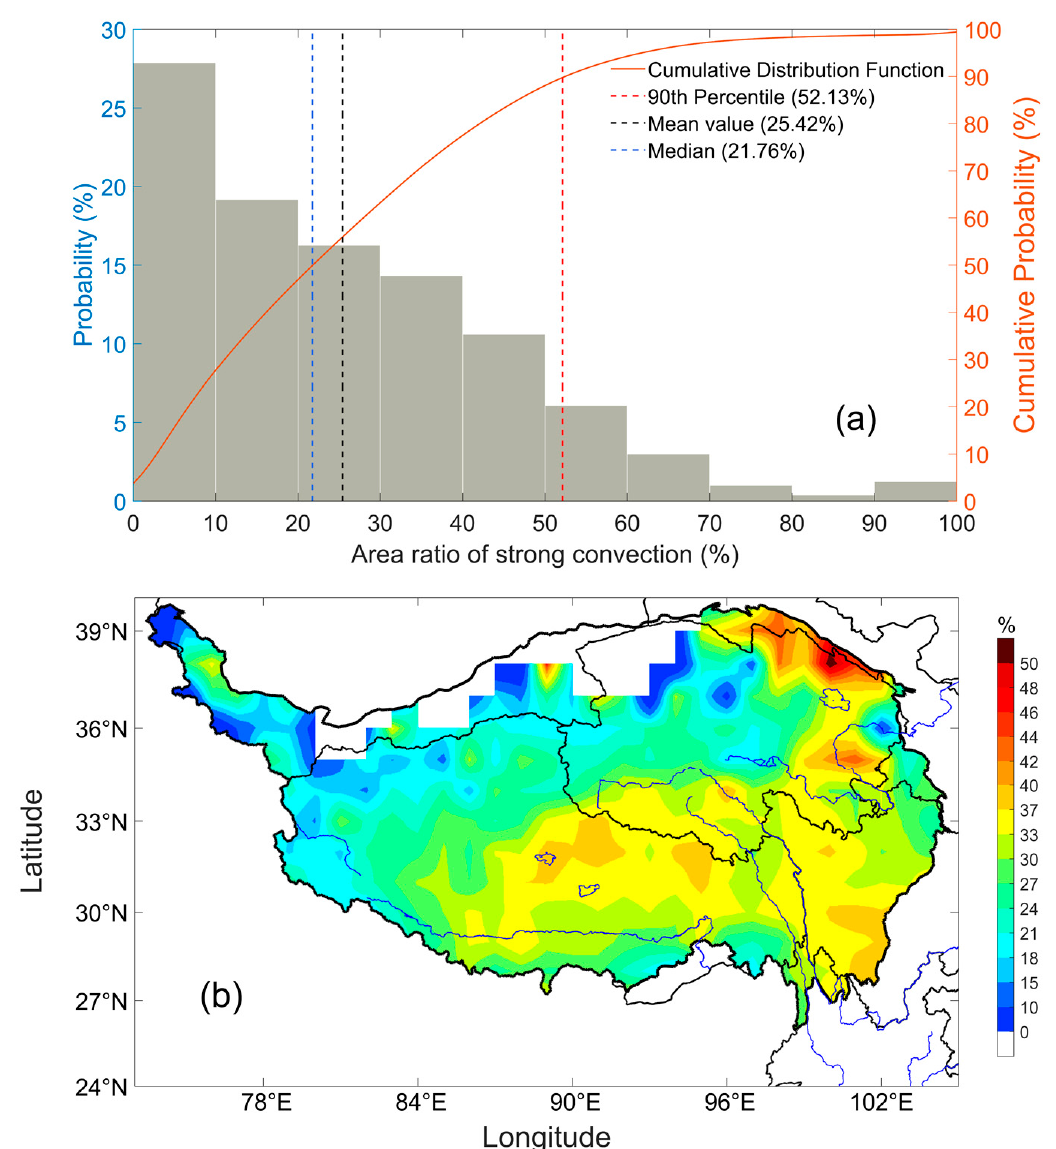
Figure 9. Probability and cumulative probability distributions ( a ) and spatial distribution ( b ) of the area ratio of SCCs in thunderstorms over the QTP during the warm season (from May to September). In ( b ), the statistical grid size is 1° × 1°.